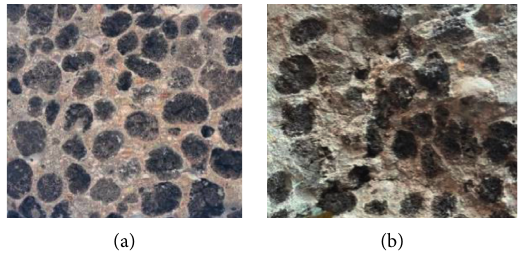
Figure 4: Uniform distribution of LWA particles: (a) LWAs and (b) LWAr (scale: 80mm × 80mm).